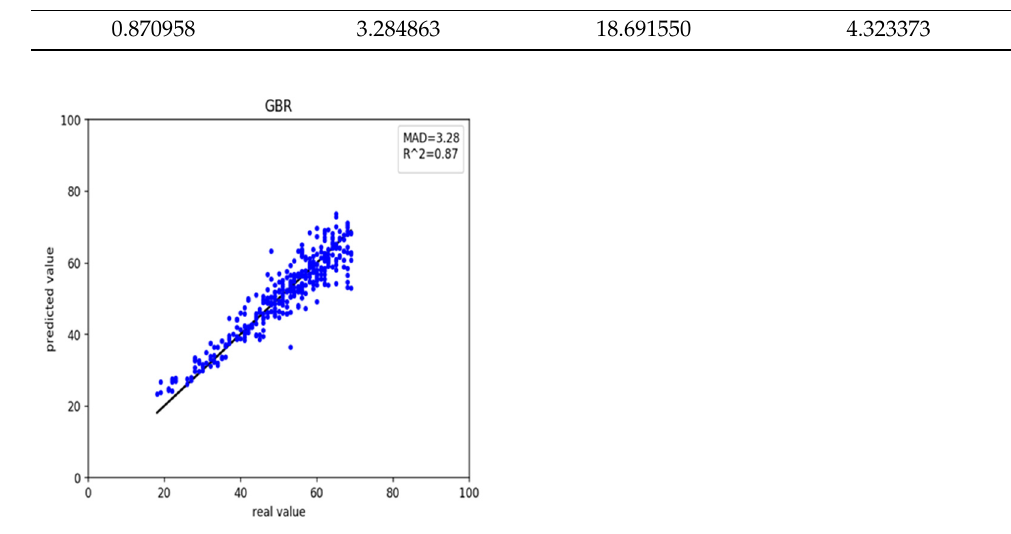
Figure 3. The scatter plot of the rheumatoid arthritis dataset with the healthy predictor. Table 4. Comparison results of our predictor with other four common regression models on rheu- matoid arthritis dataset.